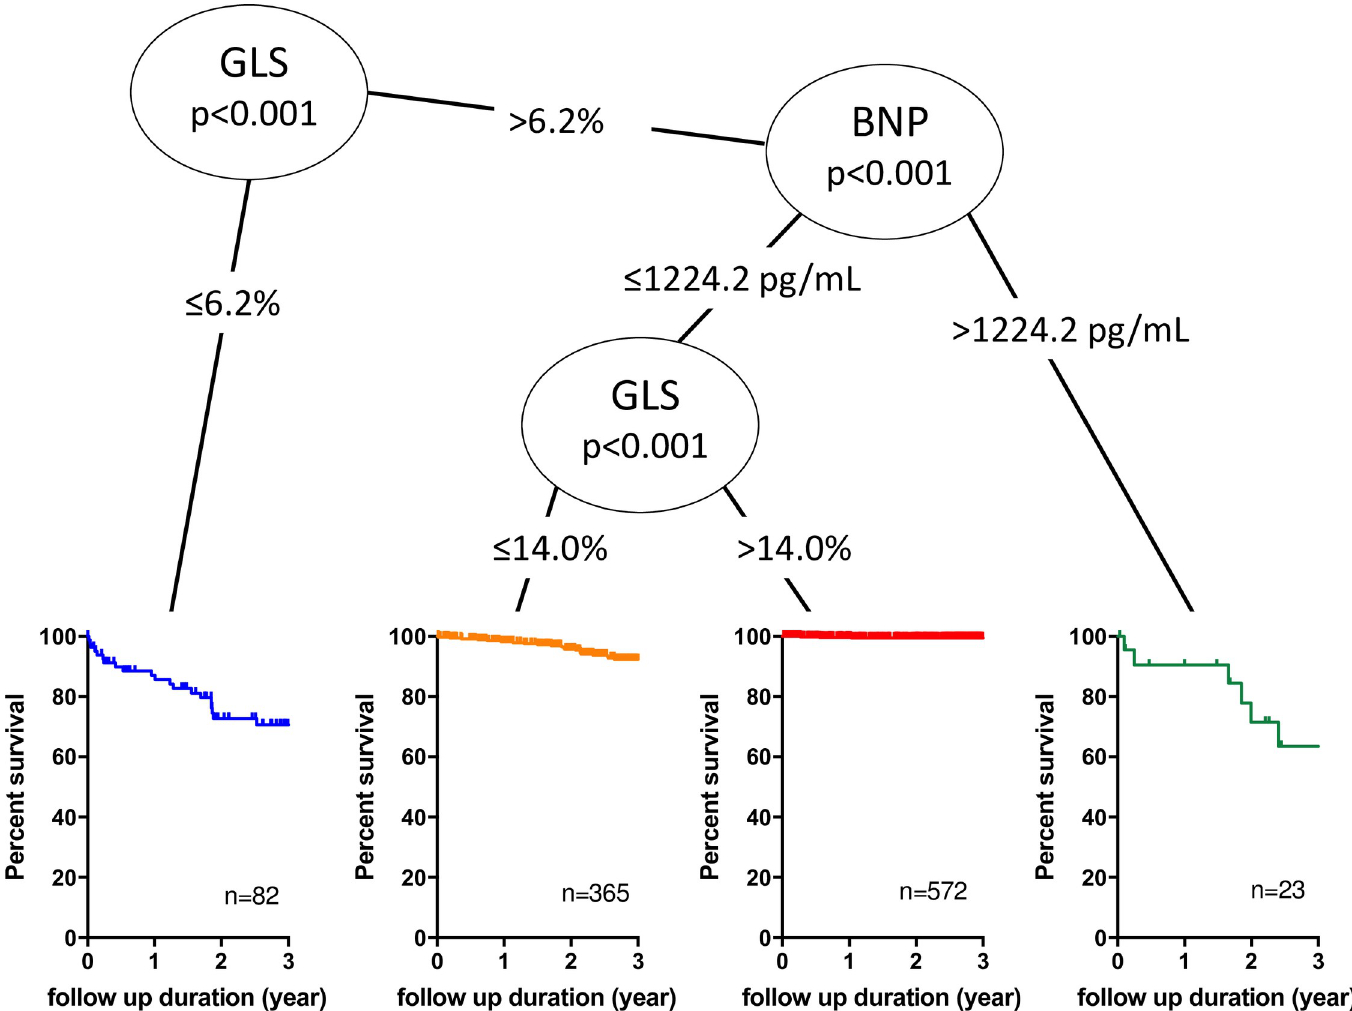
Fig 2. Optimal cut-off values of BNP and GLS, and Kaplan-Meier survival curves for predicting future cardiac death (CD) in the derivation group. Survival CART analysis identified optimal BNP and GLS cut-off values to partition the risk of CD. Colored lines represent the survival curve for CD in each subset, classified using BNP and GLS cut-off values. BNP; B-type natriuretic peptide, GLS; global longitudinal strain, CART; classification and regression